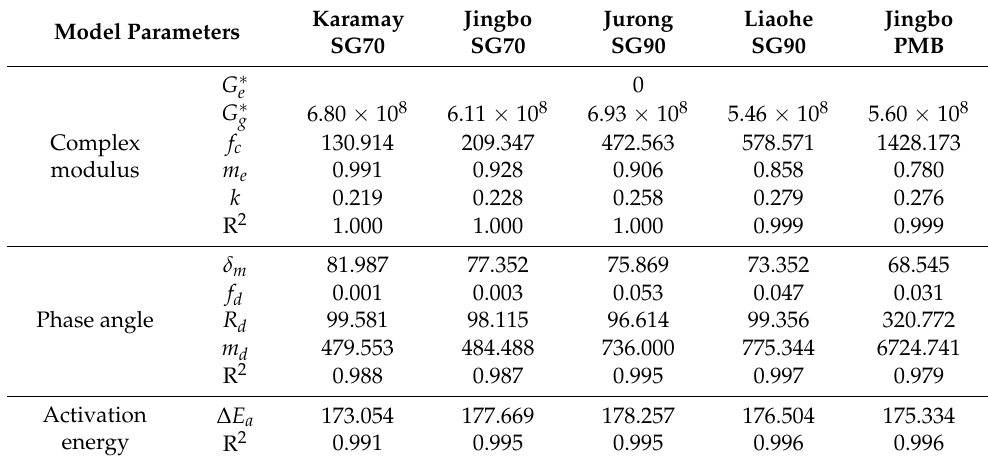
Table 3. Determination of model parameters for master